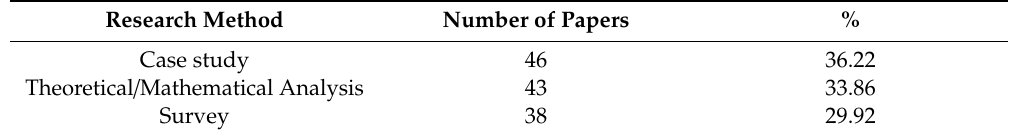
Table 1. Research methods in the sample papers.